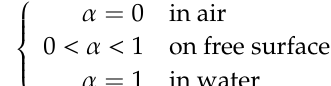
Figure 1. Two fixed floating rectangular bodies in the numerical water tank are denoted by floating body A 1 and floating body A 2 , respectively. The two floating bodies have the identical breadth B , B = 0.5 m. A narrow gap with the width B g is present between the two bodies, B g = 0.05 m. The draft depths of two floating bodies are denoted by h 1 and h 2 , respectively. The minimum value of draft depth h is 0.25 m. The range of the ratio ( h 2 / h 1 ) of draft depth considered in the study is 2.0, 1.5, 1.0, 0.67, 0.5. The depth H of the numerical water tank is 1 m. The space of fluid under the floating bodies and in the narrow gap is defined as a control volume, which is denoted by CV.